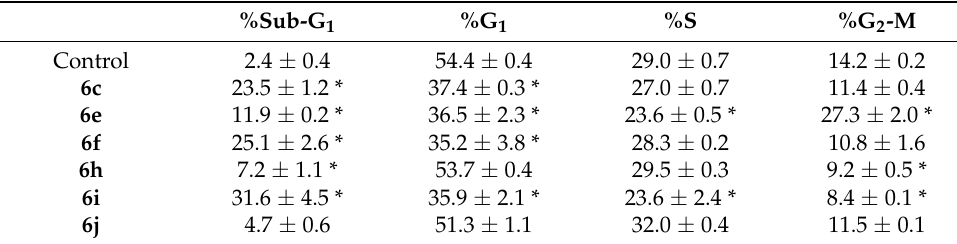
Table 3. Effect of guanidines on cell cycle phases distribution in U-937 leukemia cells.